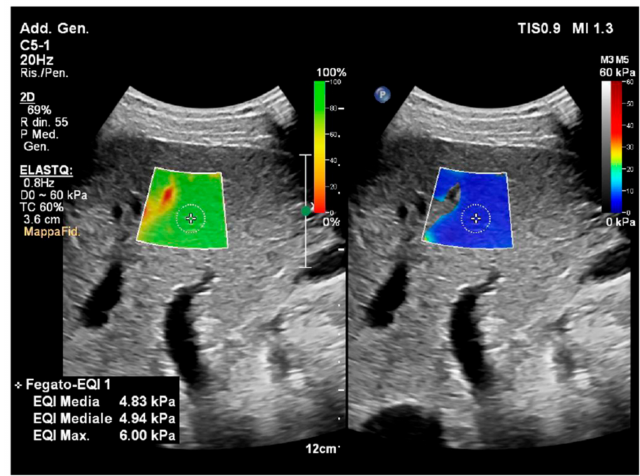
Figure 13. Confidence map and elastogram in 2D-SWE. The image is obtained via two-dimensional shear-wave elastography (2D-SWE) (ElastQ, Philips), using a convex probe in a healthy volunteer. The confidence map is displayed on the left, setting a threshold of 60%. A standard deviation of 60% or less of the mean value is indicative of a good-quality acquisition. The areas of low quality (red) are filtered out by the system and display as transparent (note that the area in red corresponds to a vascular structure on the B-mode); the yellow color is a warning indicating that the area is not of good quality; the green indicates a good quality of the measurement. On the right, the elastogram depicts a colorimetric map of the stiffness, in which the blue color corresponds to greater elasticity while red represents greater stiffness. In the elastogram on the right, a circular sampling area was inserted to obtain a quantitative measure of the stiffness value in the selected location (mean kPa 4.83). The presence of the confidence map helps the operator to check the quality of the sampling in real time.